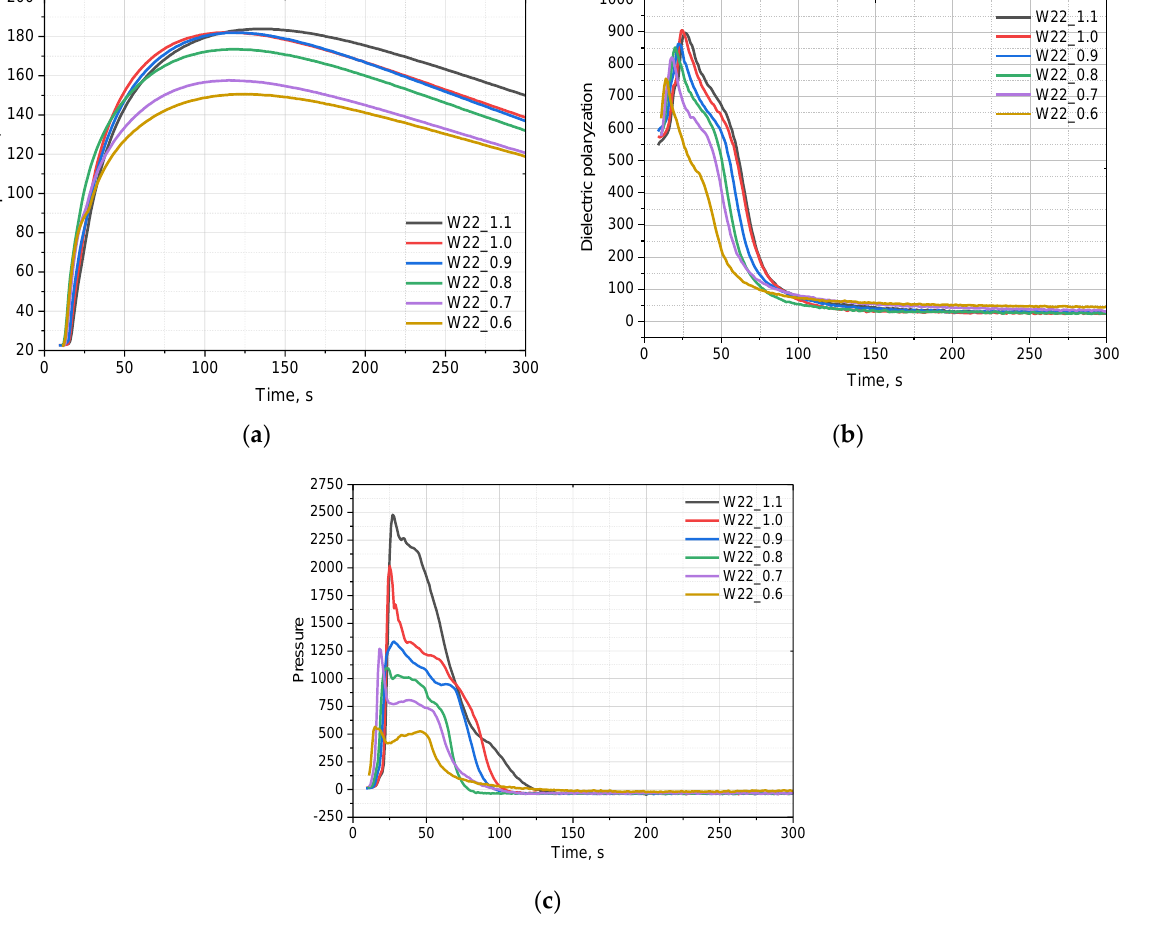
Figure 7. The influence of the isocyanate index on the system temperature ( a ), dielectric polarization ( b ), and pressure ( c ) during the foaming process.